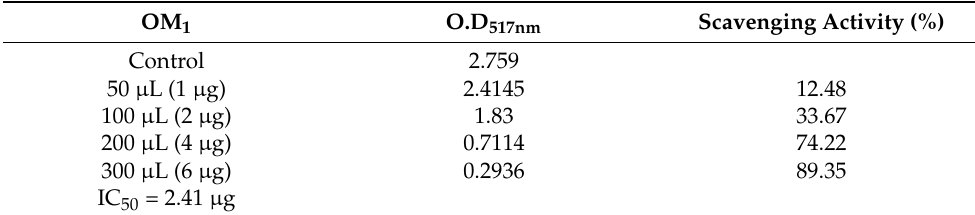
Table 5. Scavenging activity (%) of the compound OM 1 at different concentrations.